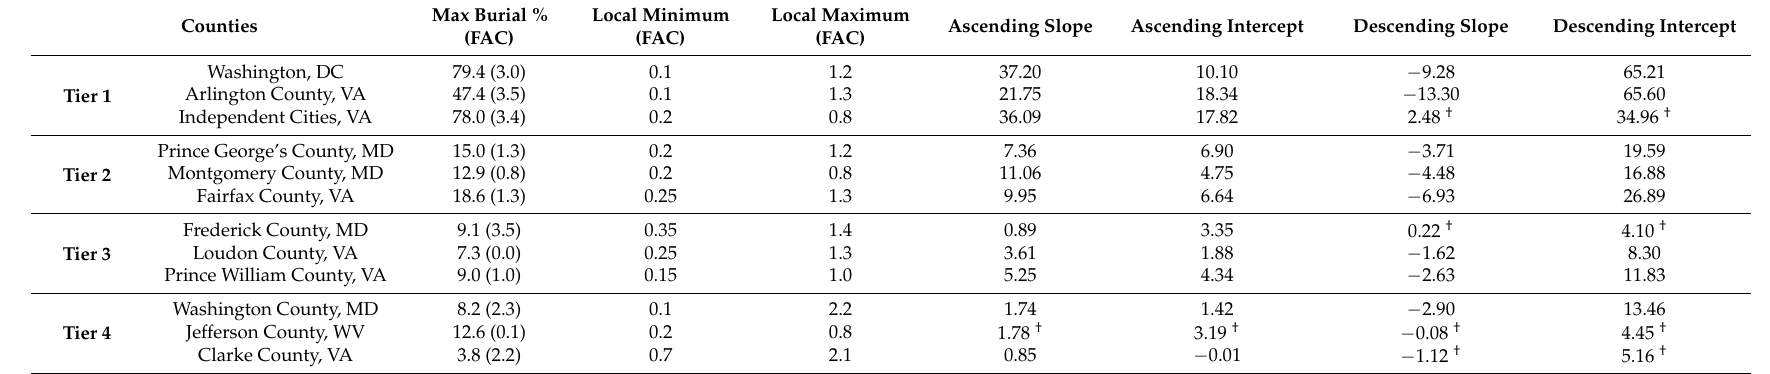
Table 4. Characteristics of the distribution of burial prediction in relation to catchment area for the sixteen study counties. Results include analyses for both the ascending and descending limbs of the burial distribution. Results with daggers ( † ) are for models where the slope of the ascending or descending limbs was not